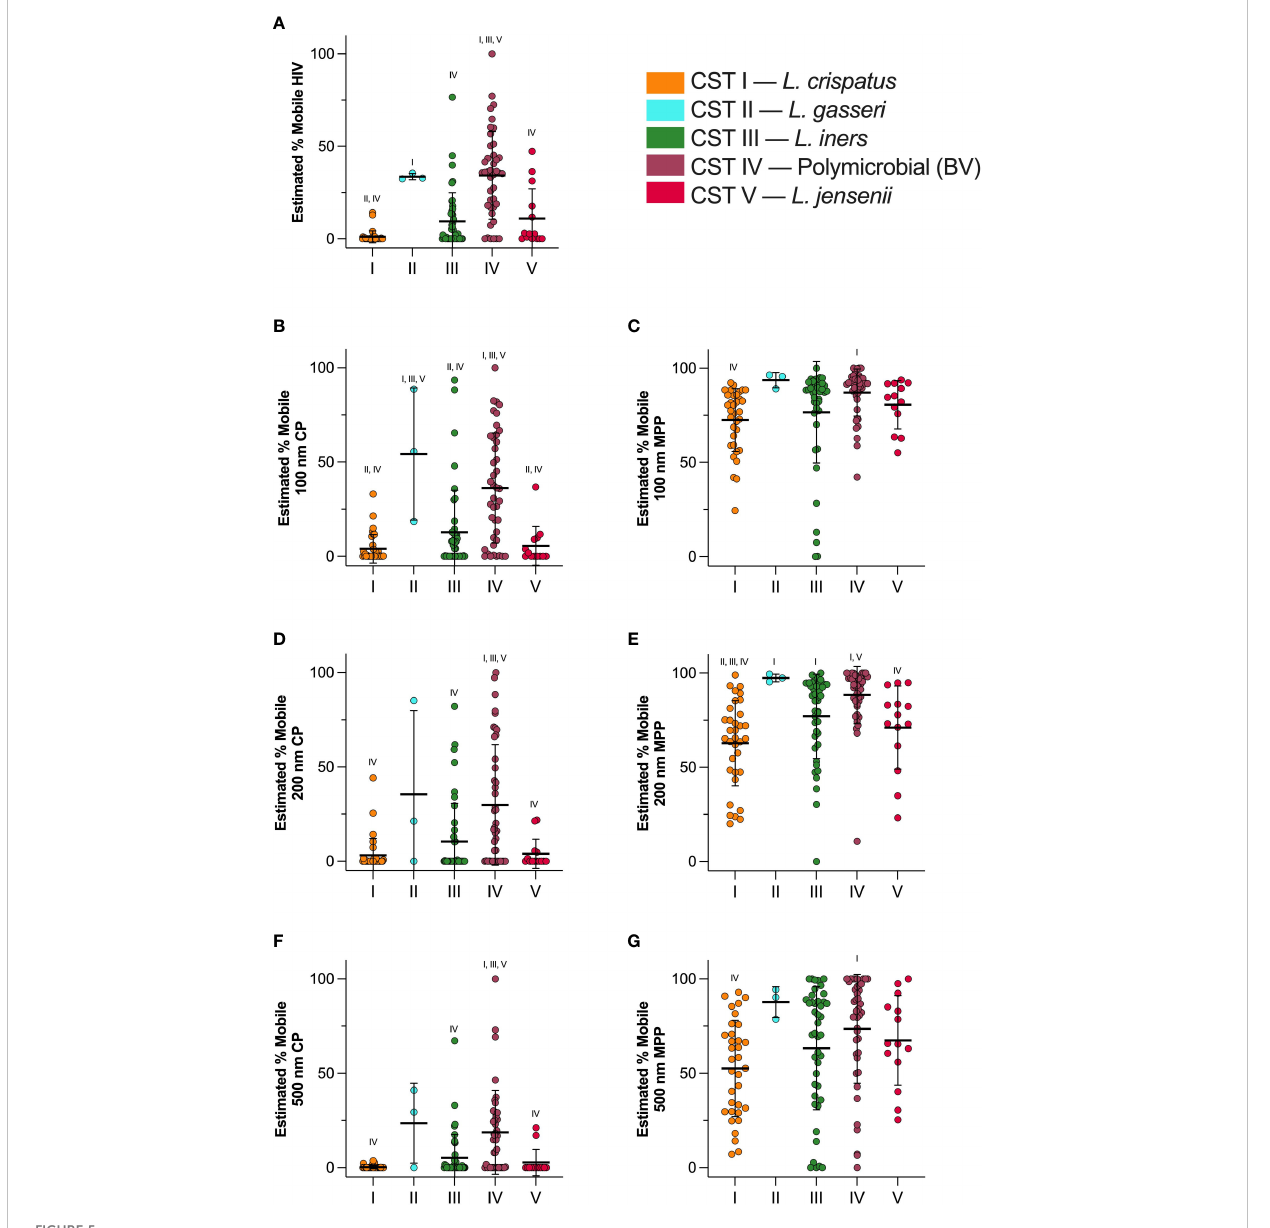
FIGURE 5 Estimated percentage of mobile particles at t = 1 s in each CST. (A) HIV virion mobility, (B) 100 nm CP mobility, (C) 100 nm MPP mobility, (D) 200 nm CP mobility, (E) 200 nm MPP mobility, (F) 500 nm CP mobility, (G) 500 nm MPP mobility. Data are shown as mean ± SD. Signi fi cant differences are represented by CST groups listed above each dataset ( p < 0.05). Signi fi cance was determined using ANOVA with Tukey ’ s multiple comparison